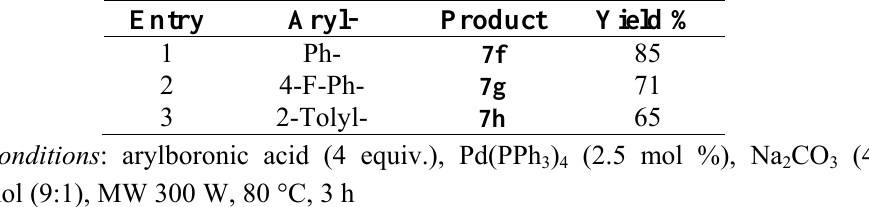
Table 2. Double Suzuki-Miyaura coupling reaction extensions in optimal